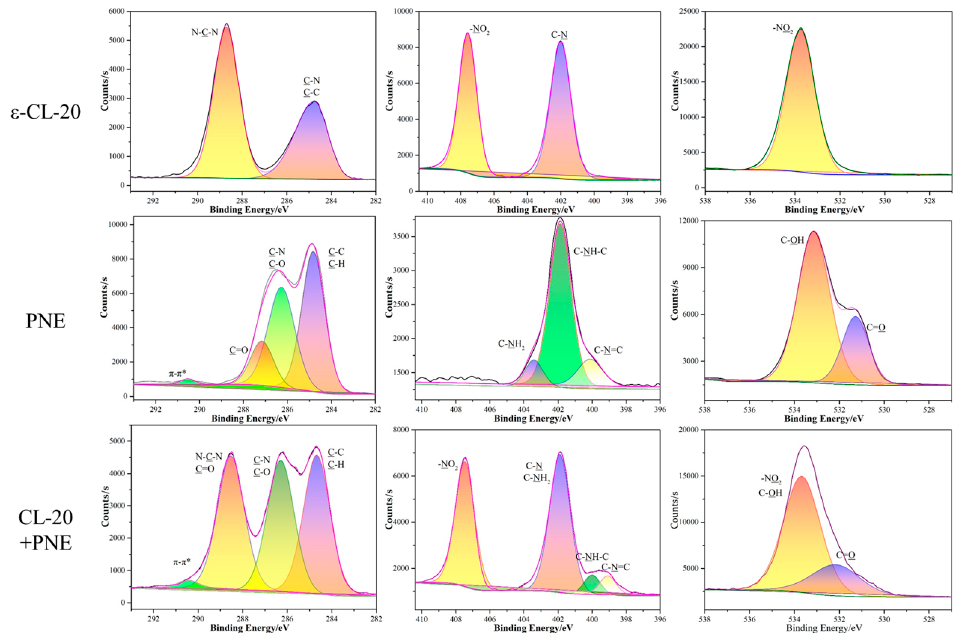
Figure 6. XPS spectra for ε‐ CL ‐ 20, PNE, and ε‐ CL ‐ 20/PNE core ‐ shell composites.